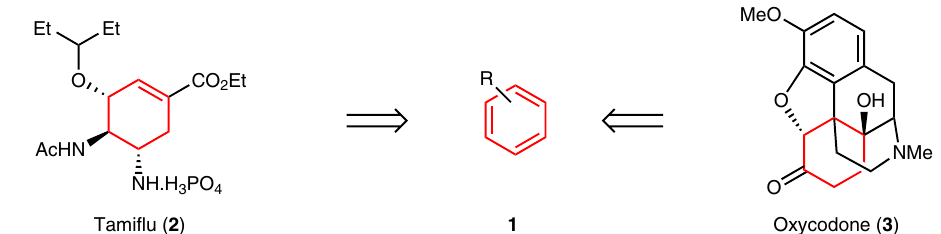
Fig.1|Representativedearomatization-basedsyntheses. Dearomatizationscanrapidlyassemblesubstituted,six-memberedringsforthesynthesisofbioactivetargets such as Tami fl u ( 2 ) and Oxycodone ( 3 ).